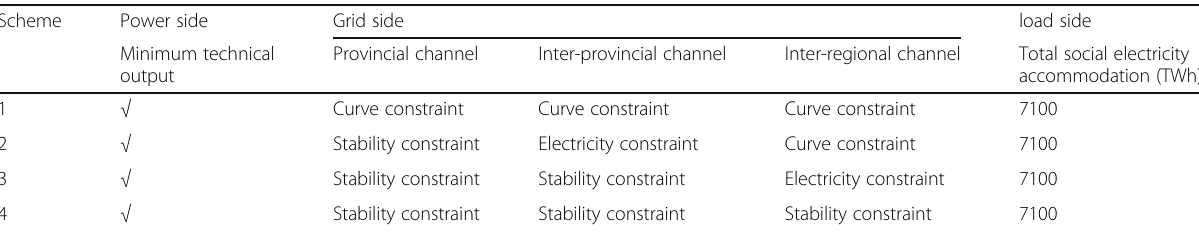
Table 2 List of case setting Scheme